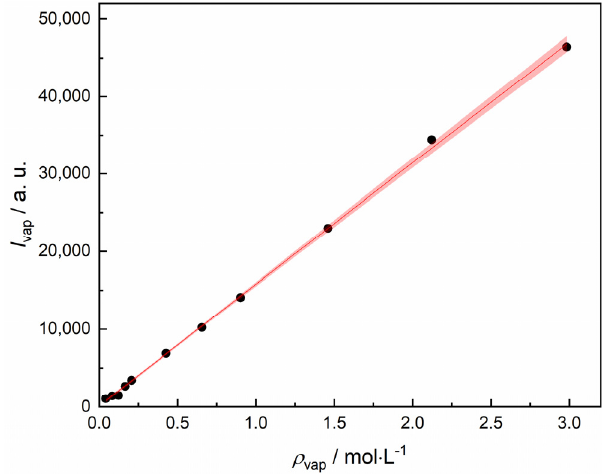
Figure 2. Example of an intensity vs. density plot of carbon dioxide at T = 293.24 K. The peak area of the right peak of the Fermi dyad, I vap , is plotted against density values calculated with an EOS, ρ vap . The slope of the linear regression line m cal (y = 20,691x, R 2 = 0.9972) is used to calculate the density of the dissolved gas molecules, ρ sol , and is given to 95% of confidence.